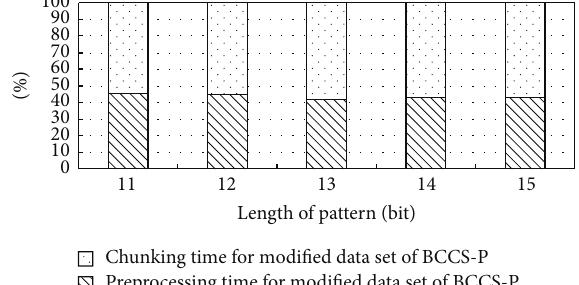
Figure 11: Ratio of chunking time and preprocessing time for modified data set of